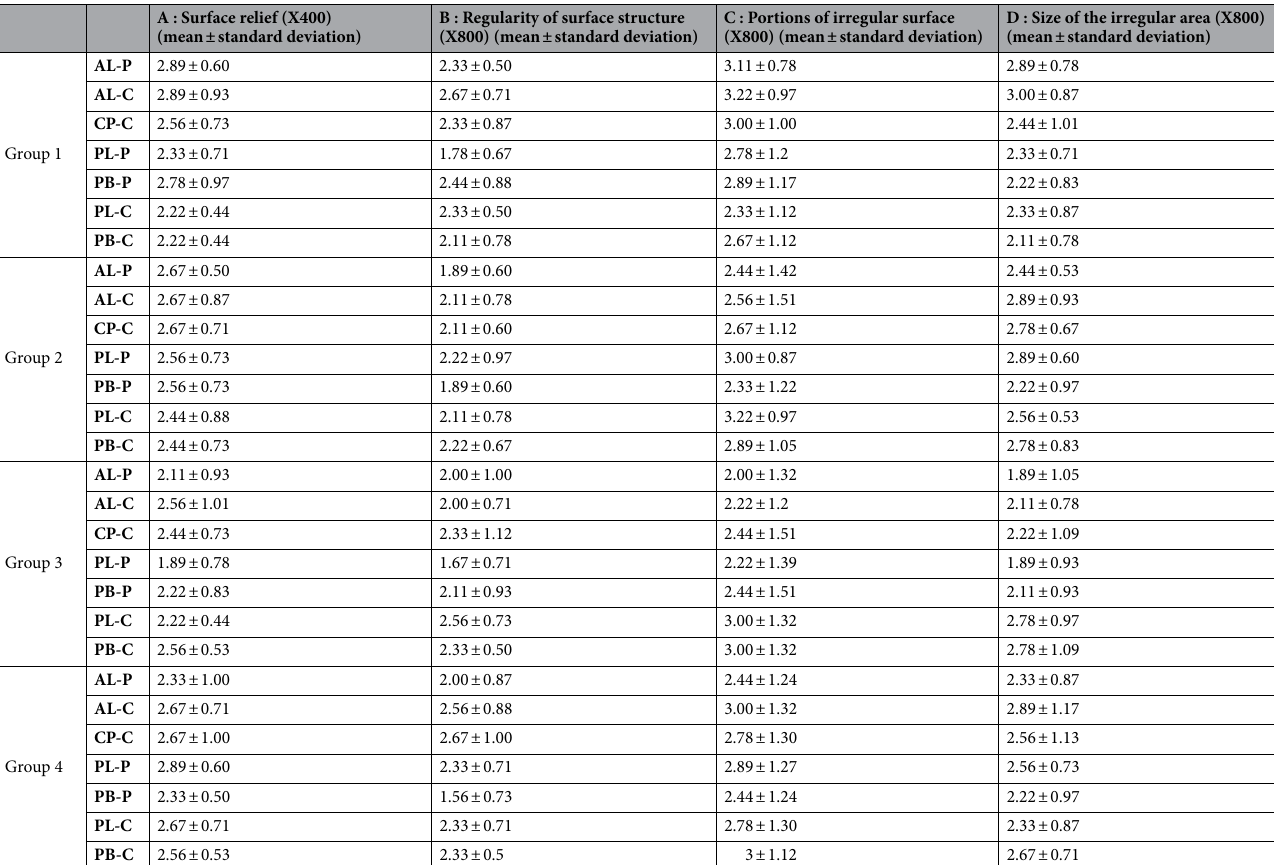
Table 2. Mean scores from all 4 graders in all 4 groups (group 1: 32% laser power for − 2.0D treatment), group 2: 64% laser power for − 2.0D treatment, group 3: 32% laser power for − 5.0D treatment and group 4: 64% laser power for − 5.0D treatment). The anterior lenticular surface periphery & centre, anterior cap centre, posterior lenticular periphery & centre and posterior stromal base centre and periphery scans were analysed. (AL-P = anterior lenticule surface periphery; AL-C = anterior lenticule surface centre; CP-C = centre of cap’s posterior surface; PL-P = posterior lenticule surface periphery; PB-P = posterior stroma base periphery; PL-C = posterior lenticule surface centre; PB-C = posterior stroma base